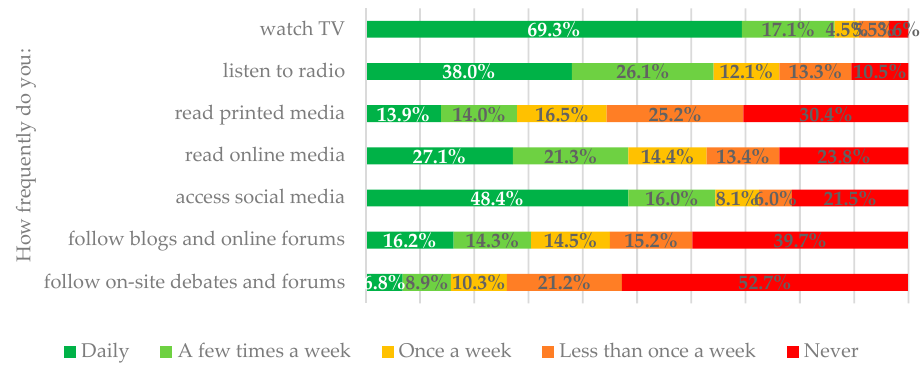
Figure 3. Media exposure of respondents.